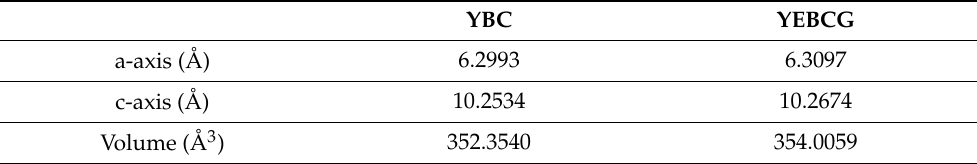
Table 1. Crystallographic parameters of YBC and YEBCG calculated by Rietveld